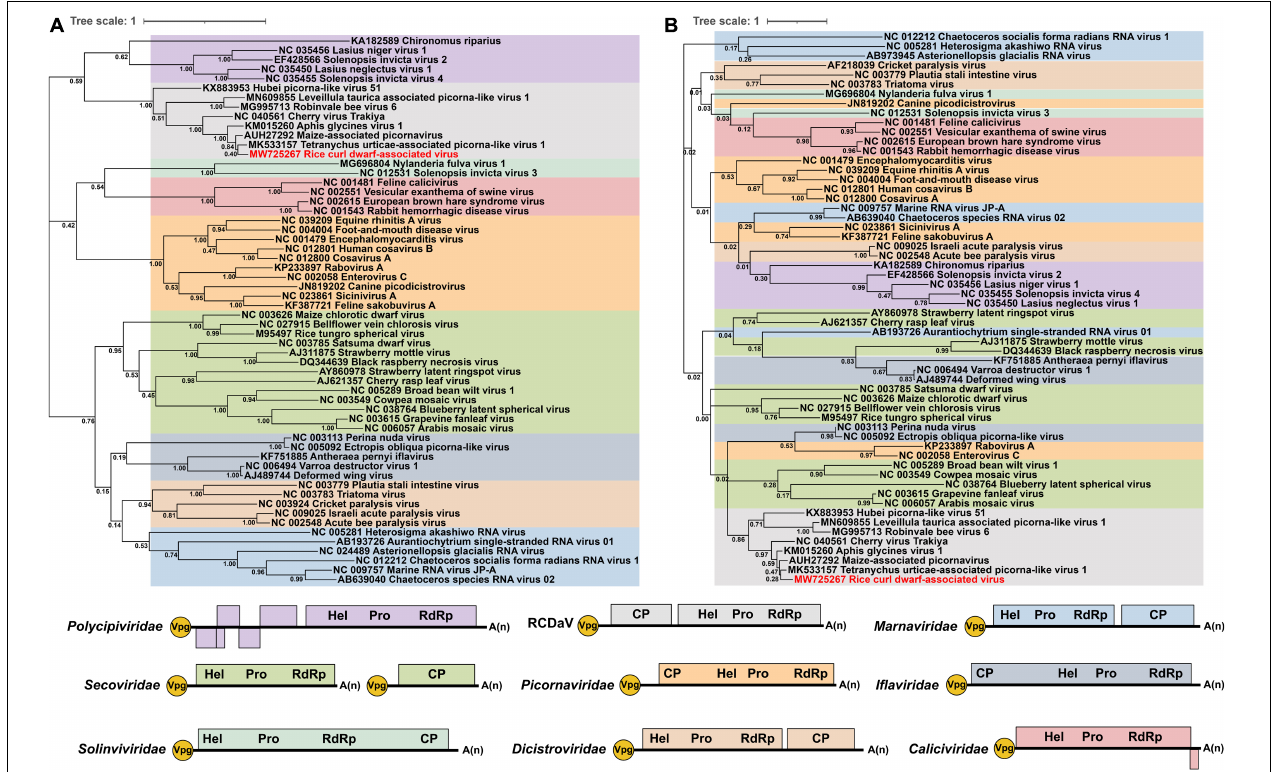
FIGURE 6 | Phylogenetic analyses using the RdRP and 3Cpro amino acid sequences from 58 viruses in the order Picornavirales . The phylogenic trees of RdRP (A) and 3Cpro (B) amino acid sequences were constructed using the maximum likelihood method with 1000 bootstraps. Among these 58 viruses, 10 were from Picornaviridae , four from Caliciviridae , two from Solinviviridae , five from Polycipiviridae , six from Marnaviridae , five from Dicistroviridae , five from Iflaviridae , 13 from Secoviridae , seven from unclassified picornaviruses, and one from rice curl dwarf-associated picornavirus (RCDaV). Viruses from the same family are shown in the same color. The name of RCDaV is shown in red. The bottom panel shows the schematic diagram of genome organizations of different families used in this analysis. Virus names and their GenBank or Refseq accession numbers are listed in Supplementary Table 3